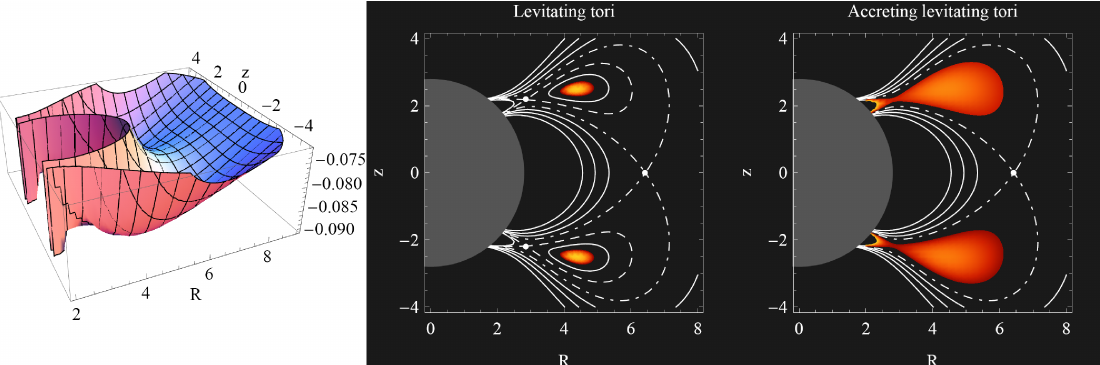
Figure 23. Typical behavior of the potential W for the charged fluid shown in terms of its poloidal equipotential contours—continuation of Figure 22.